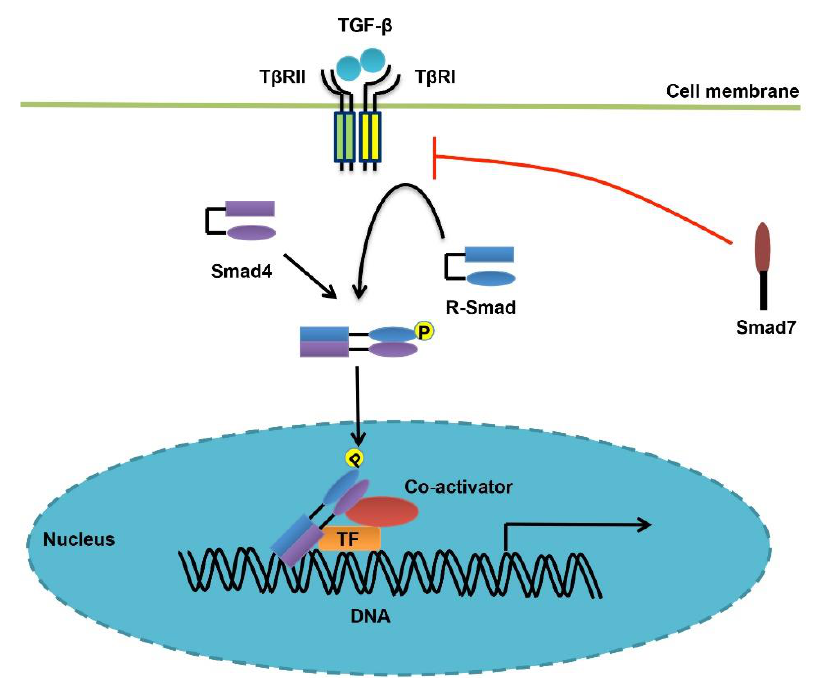
Figure 1. Overview of TGF-β/Smad signaling . Once associated with TGF-β ligands, the constitutively active TβRII forms a complex with and phosphorylates TβRI, leading to activation of its kinase activity. Then, TβRI proceeds to phosphorylate R-Smads (Smad2/3) at the extreme C-terminal SXS motif, causing their oligomerization with Smad4, translocation into the nucleus, binding to DNA, and finally regulation of target gene transcription, in concert with other transcription factors and co- regulators. In addition, the inhibitory Smad Smad7 exerts a critical regulatory effect over TGF-β/Smad signaling, in a feedback manner and via multiple mechanisms.